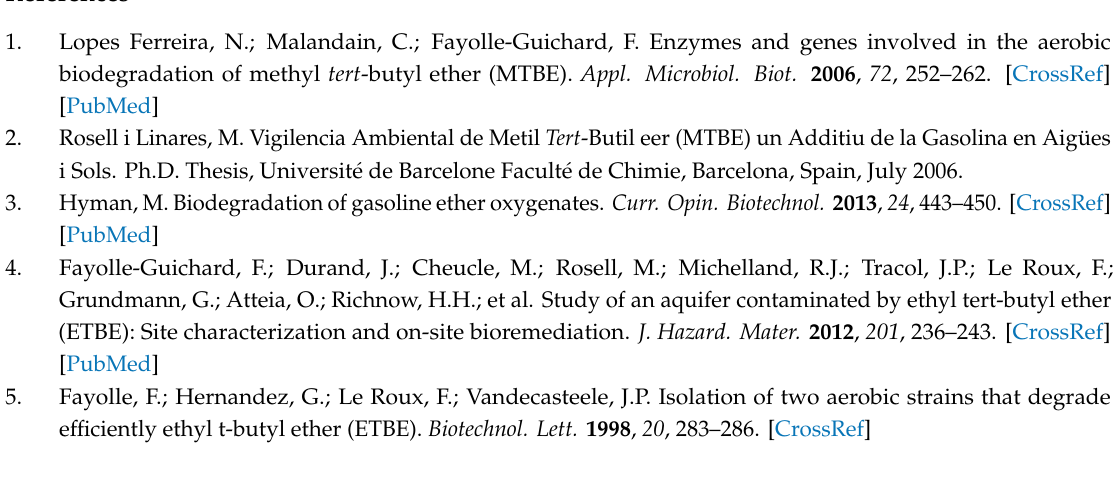
s1, Figure S1: A simplified overview of the ETBE-enrichment cultures from PW and UW water and their biodegradation properties, Figure S2: Microarray comparisons of bacterial communities between PW and UP water, PW water and PW ETBE-enrichments, UP water and UP ETBE-enrichments, and PW ETBE-enrichments and UW ETBE-enrichments, Figure S3: Analysis of the 16S rRNA gene diversity in UW and PW water and ETBE-enrichment subcultures based on cloning-sequencing, Figure S4: Comparison of UW and PW water bacterial communities by 16S rRNA gene sequencing, Figure S5: Degradation of ETBE and TBA in UW ETBE-enrichment subcultures S1–S3 and PW ETBE-enrichment subcultures S1–S3, Figure S6: Phylogeny analysis of 16S rRNA clones from the UW ETBE-enrichment subculture S1, Figure S7: Phylogeny analysis of 16S rRNA clones from the PW ETBE-enrichment subculture S3, Table S1: List of new microarray probes designed in this study and their